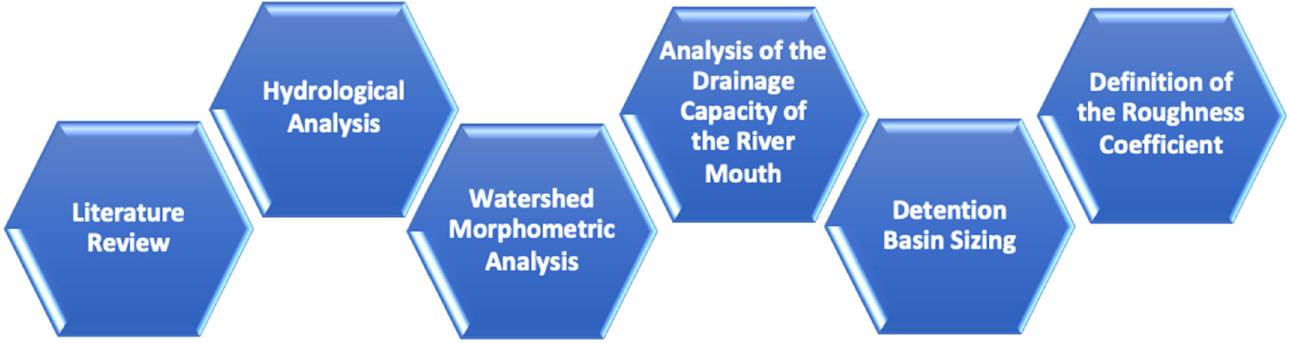
Figure 2. State of conservation of São Vicente main watercourse river mouth.